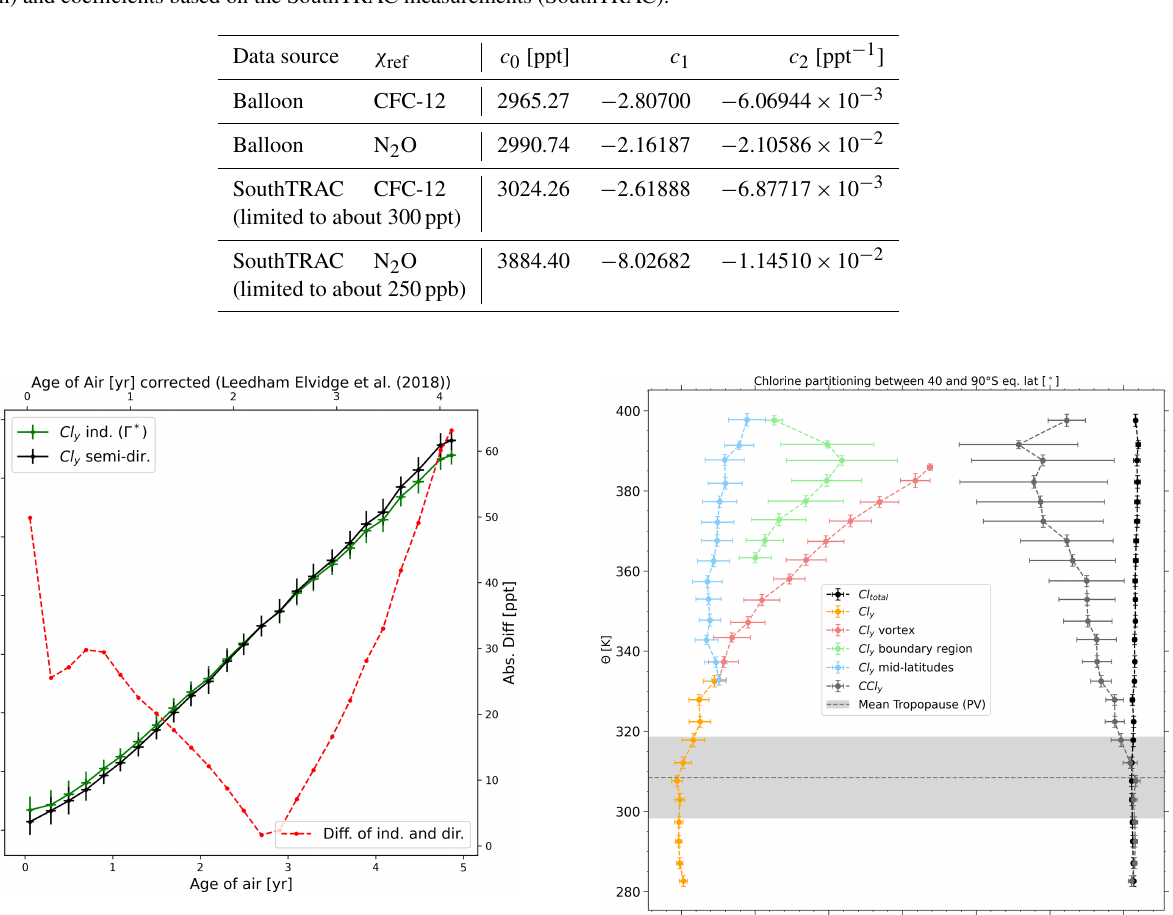
Figure 7. Indirectly (green) determined Cl y based on balloon ob- servations in 2009 and 2011 and semi-directly (black) determined Cl y as a function of age of air (bottom axis) and corrected age of air (top) using a linear fit y = 0 . 85 x − 0 . 02 from Leedham Elvidge et al. (2018). The absolute difference between these methods is shown in red.